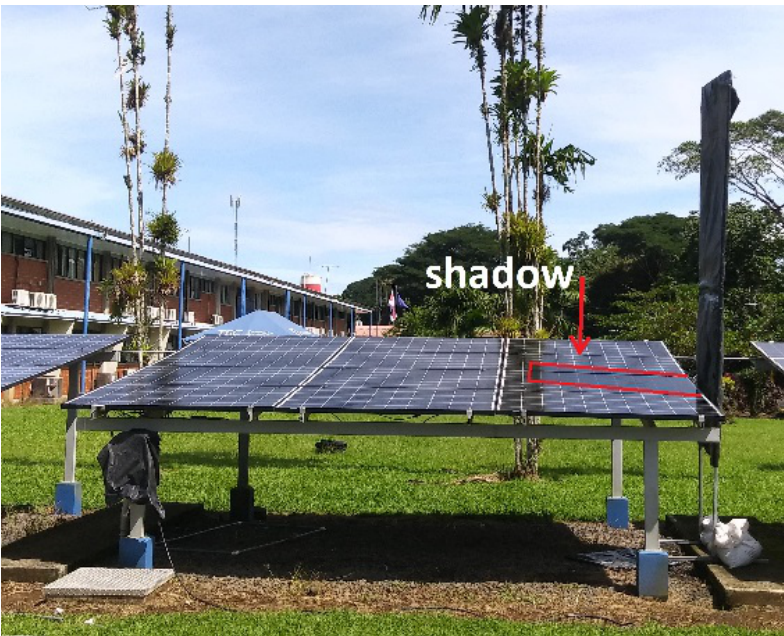
Figure 7. Object used to generate partial shade conditions. The shadow generated corresponds to the PS1 suboptimal